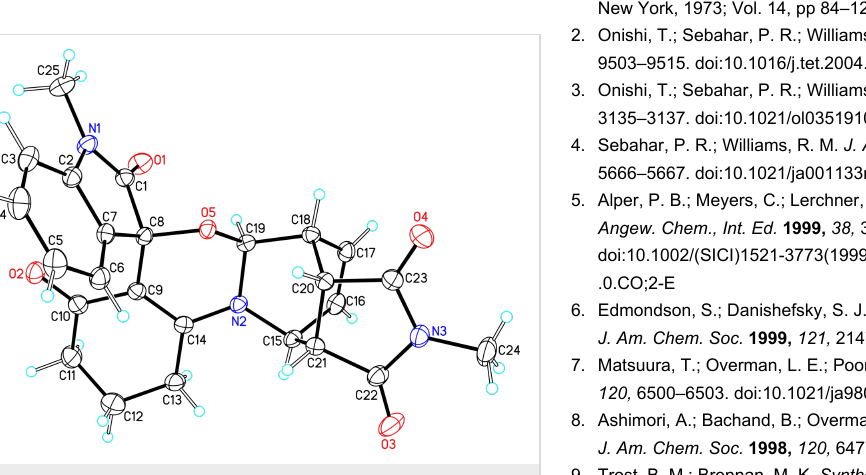
Figure 3: X-ray crystal structure of compound 8a